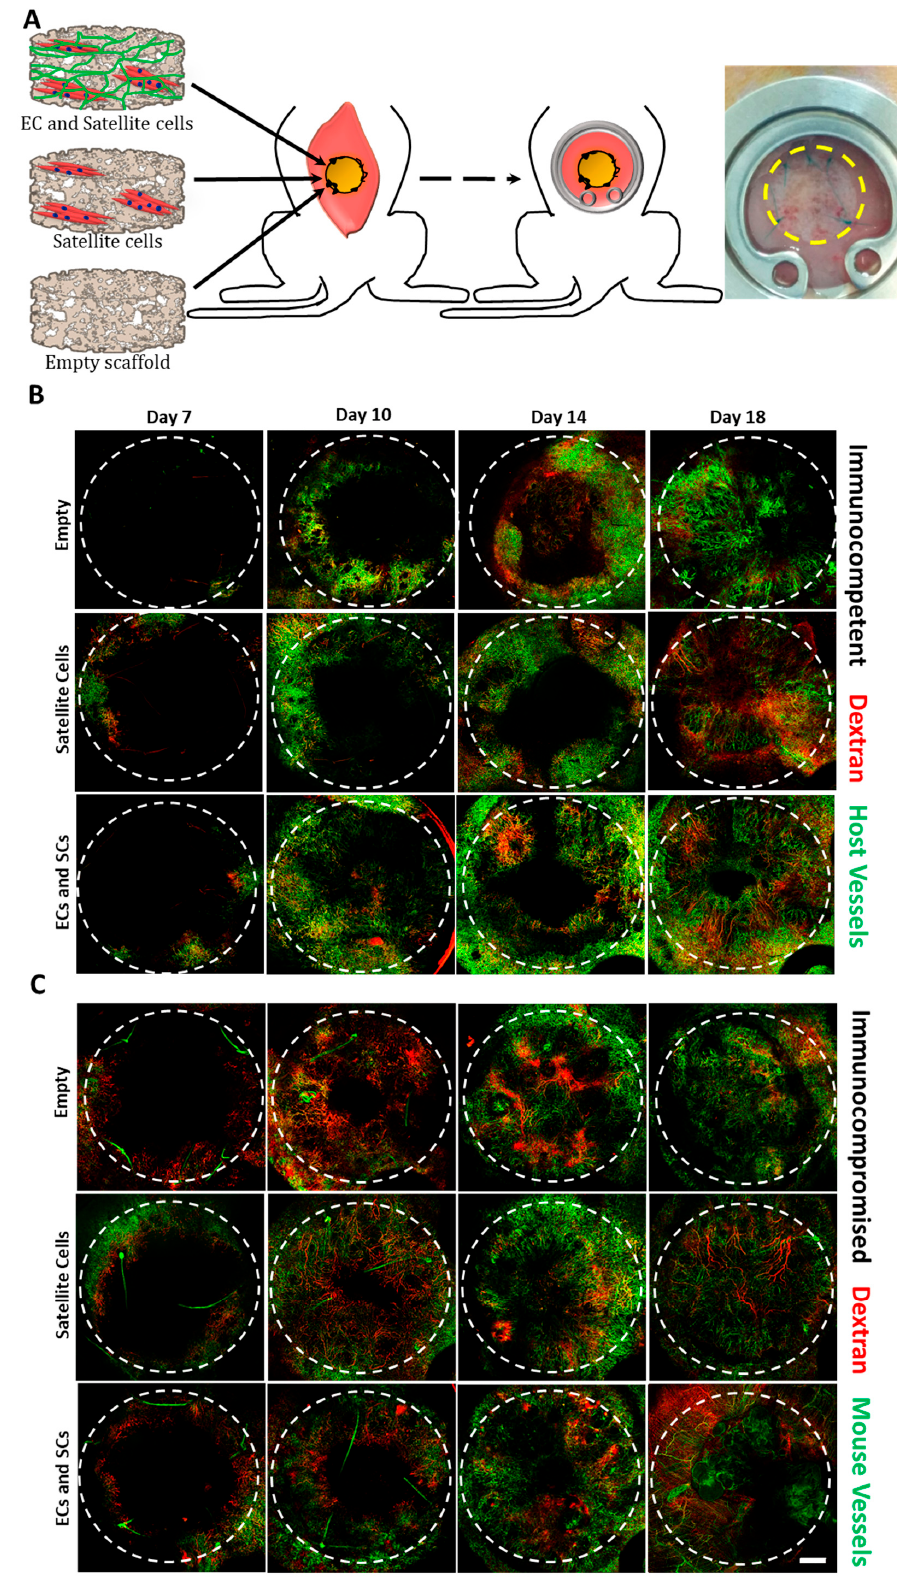
Figure 2. Intravital imaging. ( A ) A schematic presentation of engineered tissue transplantation into defects created in the rectus abdominis muscle of mice, and a representative image of a mouse with an abdominal imaging window (AIW) immediately post-surgery. The area of the transplanted graft is indicated by a yellow dashed circle. Empty, SC-only, and EC-SC-containing scaffolds were